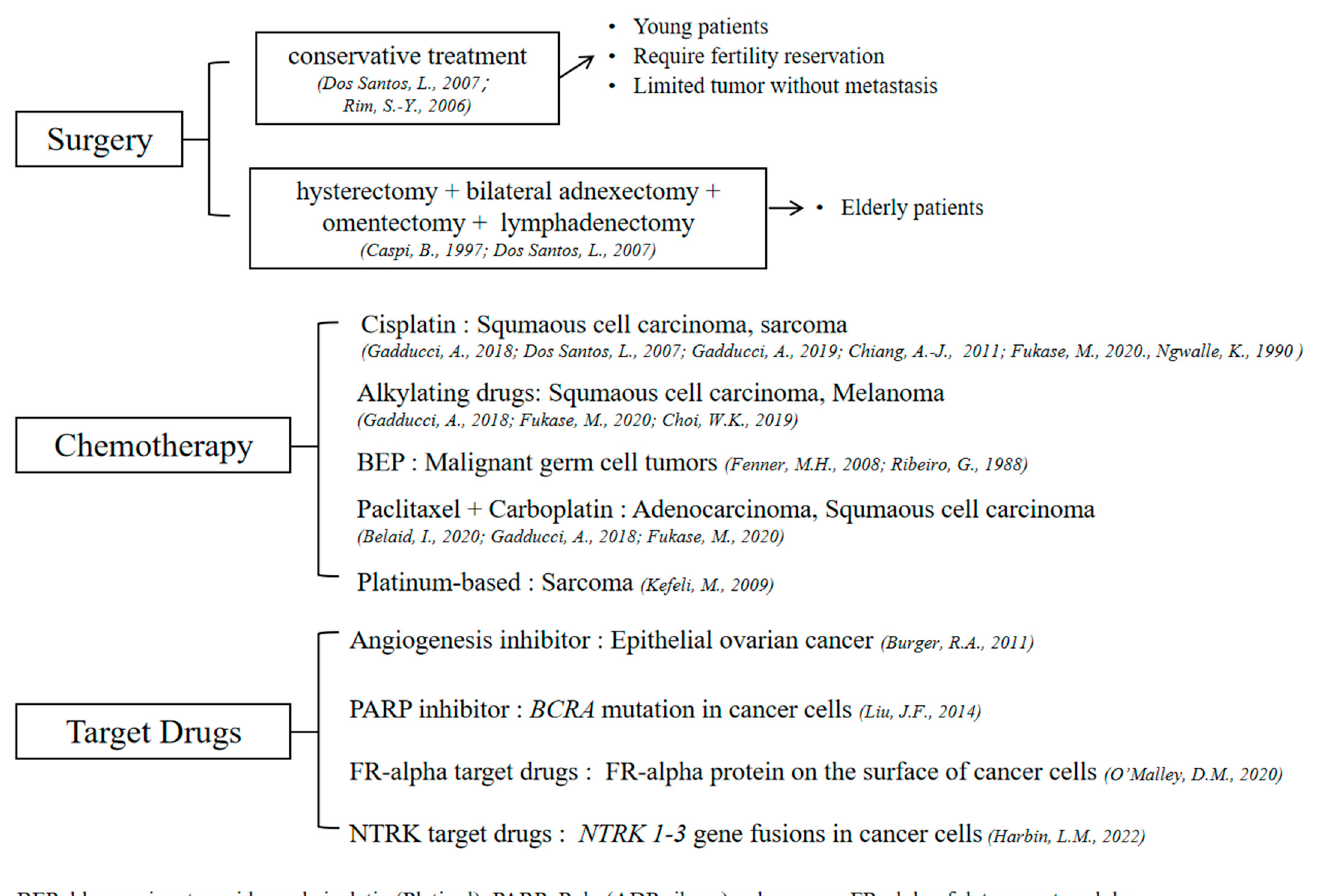
Figure 2. Treatment options for malignant transformations [21,22,27,34,35,79,